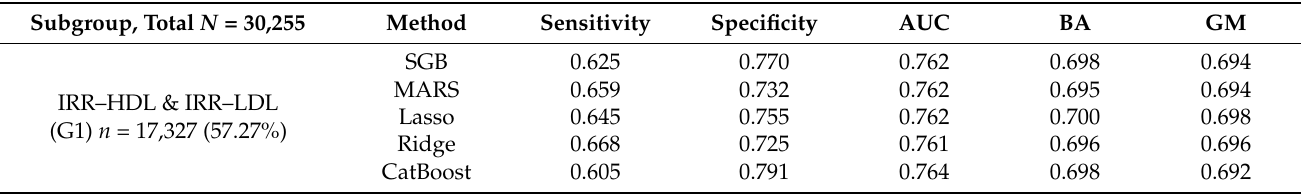
Table 3. Model performance in predicting hypertension for HDL and LDL IRR/ORR subgroups. Subgroup, Total N =